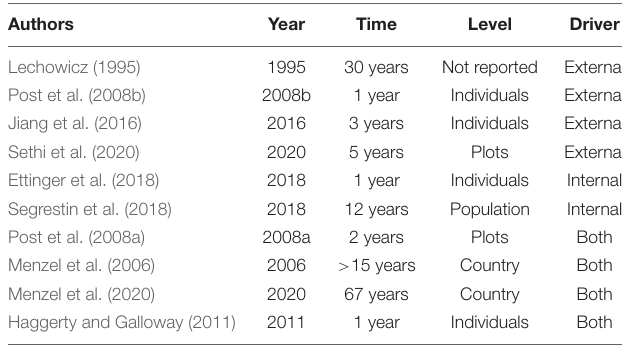
TABLE 1 | Evidence from previous observational and experimental studies on the length of the flowering to fruiting interval (FTFI), the time between the flowering and ripe fruit phenophases, and for external and internal drivers of FTFI